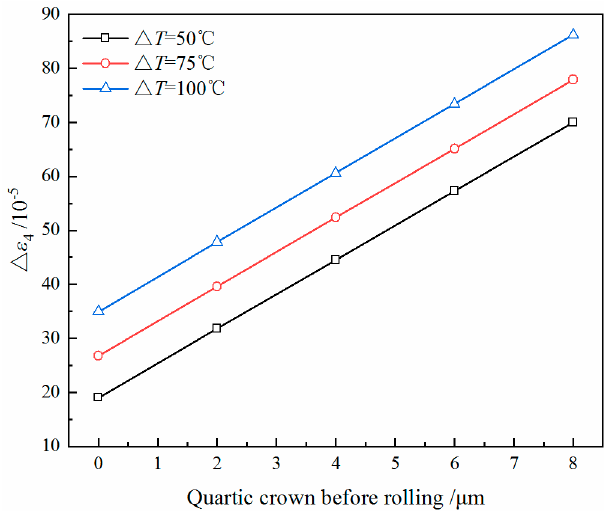
Figure 18. The value of Δ ε 4 of the strip with different quartic crowns before rolling. Metals 2020 , 10 , x FOR PEER REVIEW